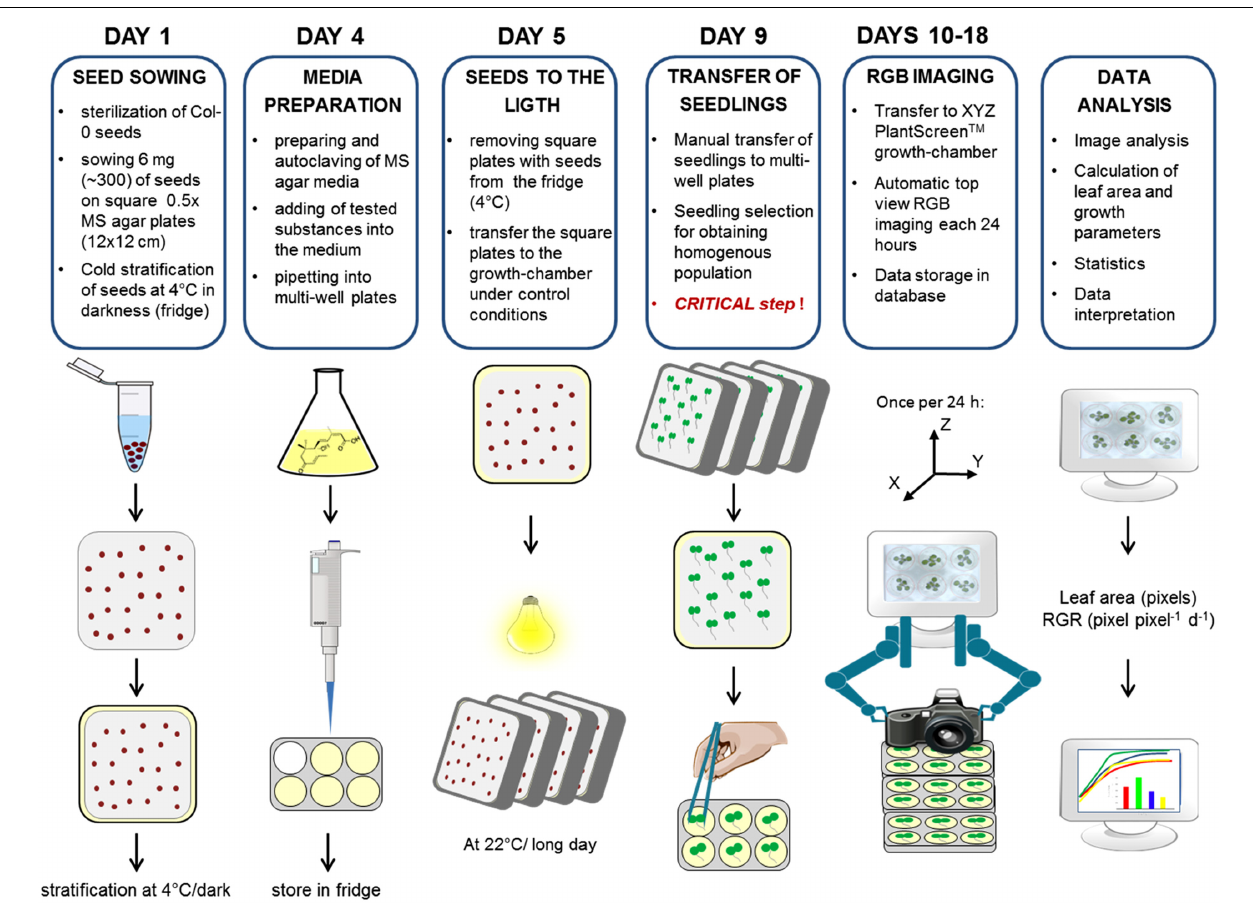
FIGURE 2 | Protocol for high-throughput phenotyping for screening of Arabidopsis rosette growth in multi-well plates. Col-0 were germinated in 0.5 × MS under long day controlled conditions. Seedlings of similar sizes were transplanted into multi-well plates with fresh MS medium 4 days after cold stratification. Plates were transferred to a XYZ PlantScreenTM growth-chamber for automatic RGB imaging and data analysis.